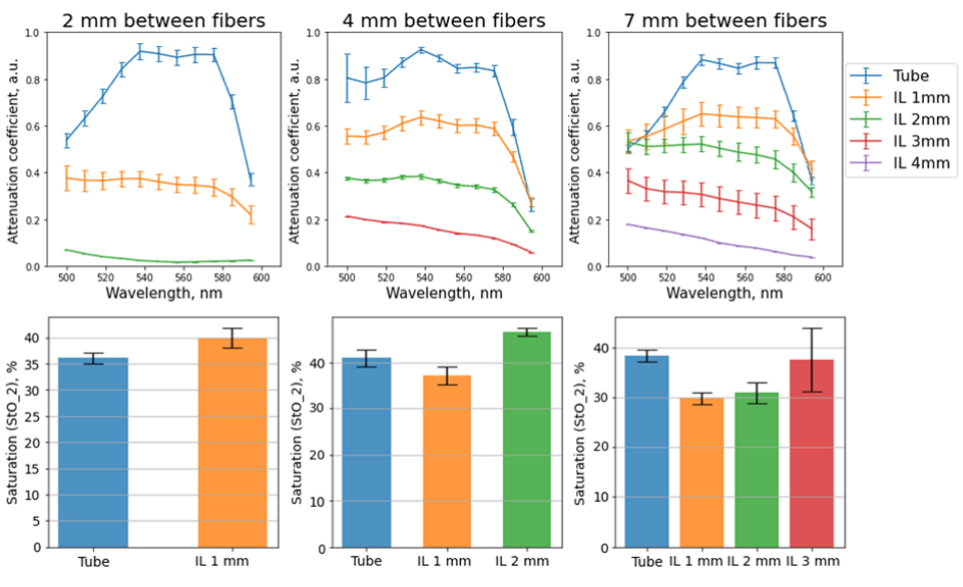
Figure 3. The attenuation coefficient spectra obtained at a distance between the emitting and detecting fibers of 2, 4, and 7 mm ( top row) and diagrams showing the level of oxygen hemoglobin saturation calculated from the measured spectra ( bottom row). The maximum signal detection depth is 3 mm at a distance between the fibers of 7